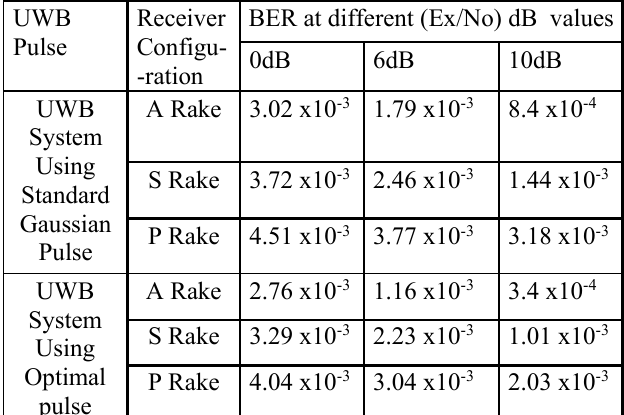
Table3. Bit error rates at different normalized signal